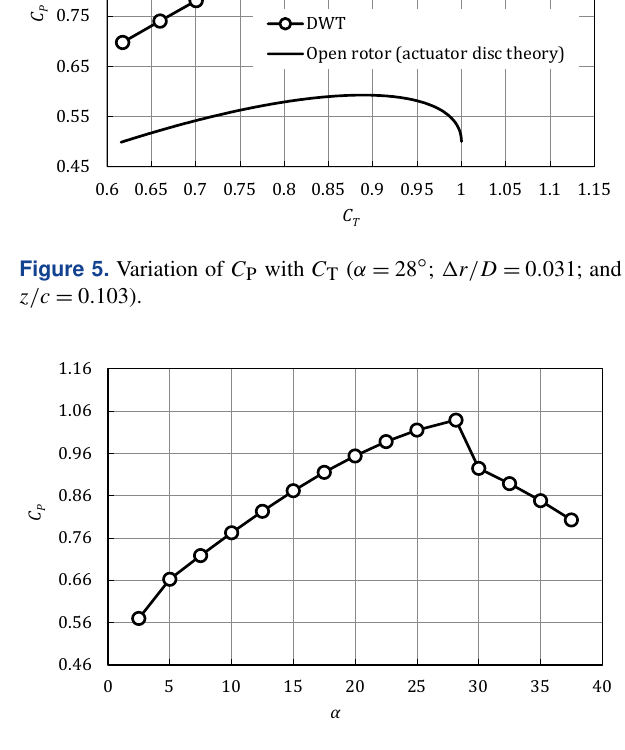
Figure 6. Variation of C P with α ( C T , rotor = 0 . 763; (cid:49)r/D = 0 . 031; and z/c = 0 . 103).